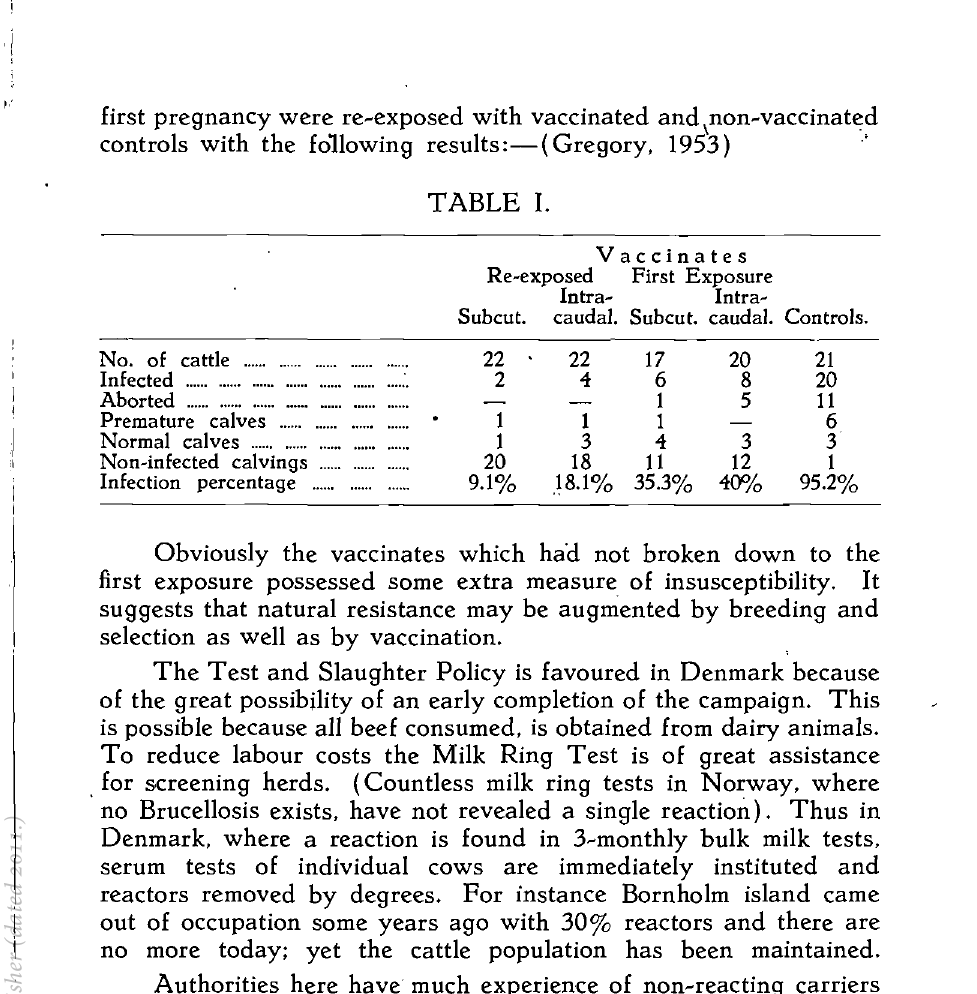
Vaccinates Re-exposed First Exposure Intra- Intra-